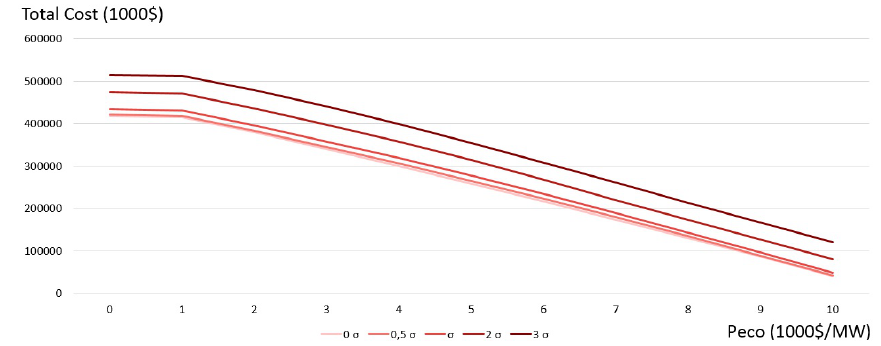
Figure 15. Variation of the optimal total cost with respect to P eco and σ in case of log-normal distribution (own